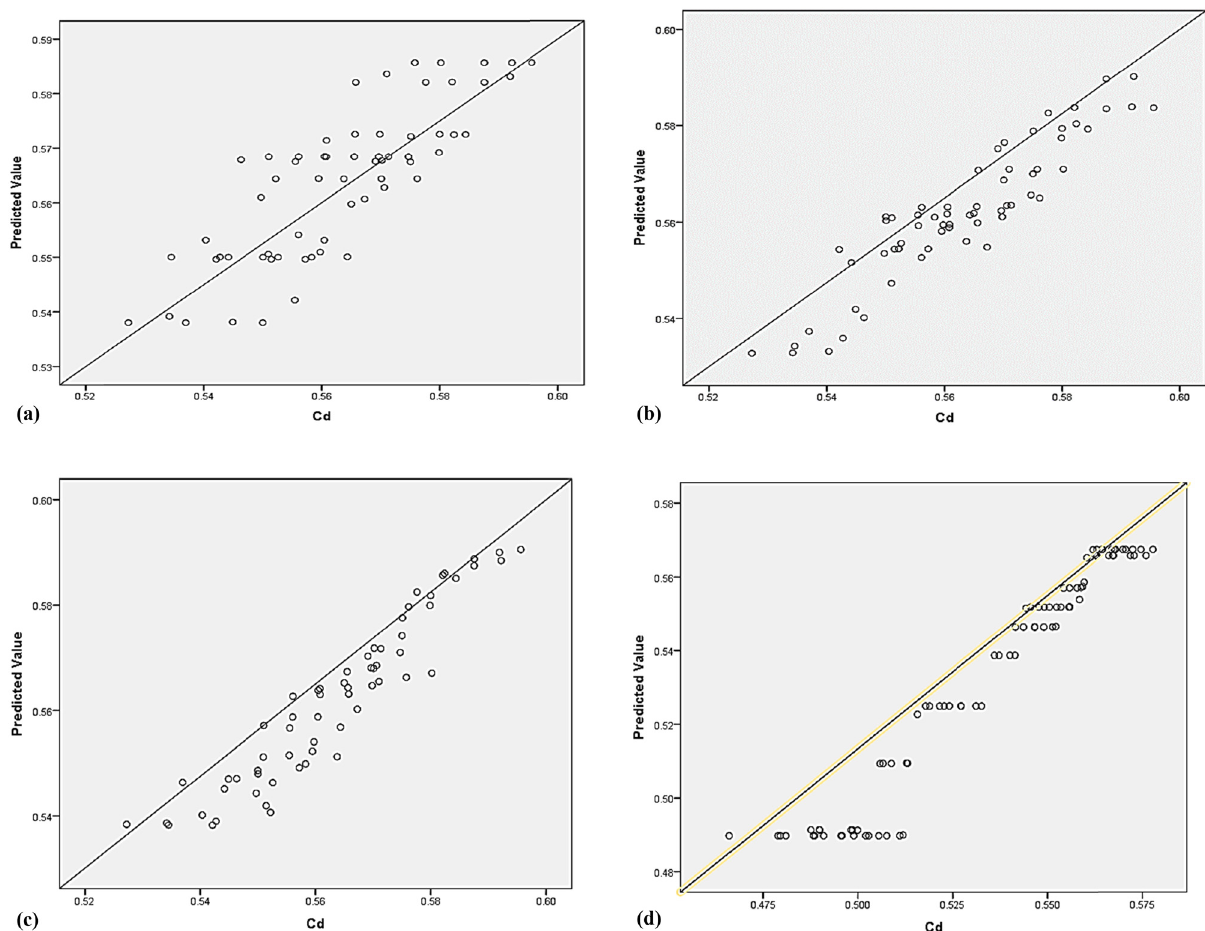
Figure 6: ( a – d ) Results of development of ANN for di ff erent inputs by SPSS V24 software. ( a ) Input h / d , H / d , y / d , tan θ , ( b ) input h / d , H / d ,